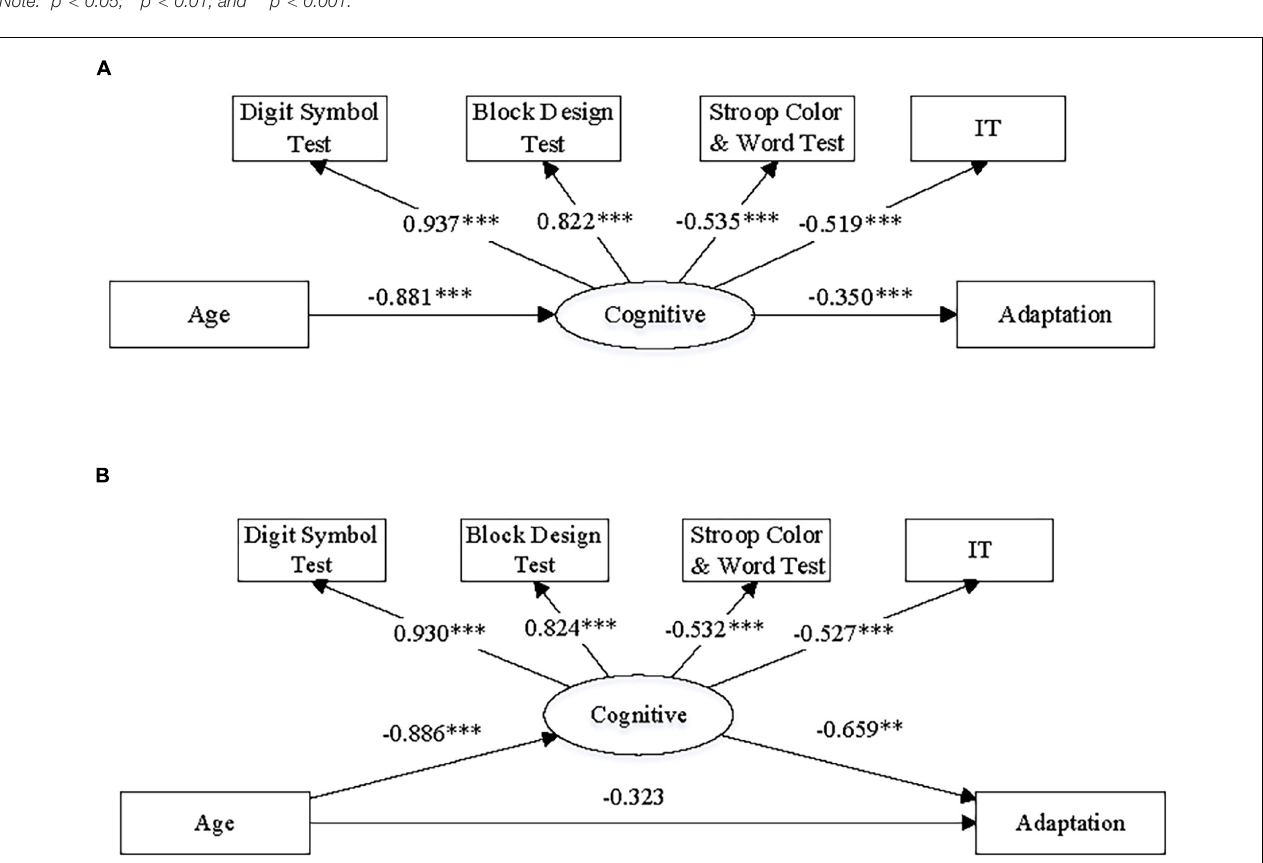
FIGURE 8 | The diagrams illustrate the structures and summary results of (A) the full mediation structural equation model and (B) the partial mediation structural equation model, respectively. The numbers on the paths of the diagrams refers to standardized coefficients. Note, (1) “Cognitive” refers to cognitive resources;